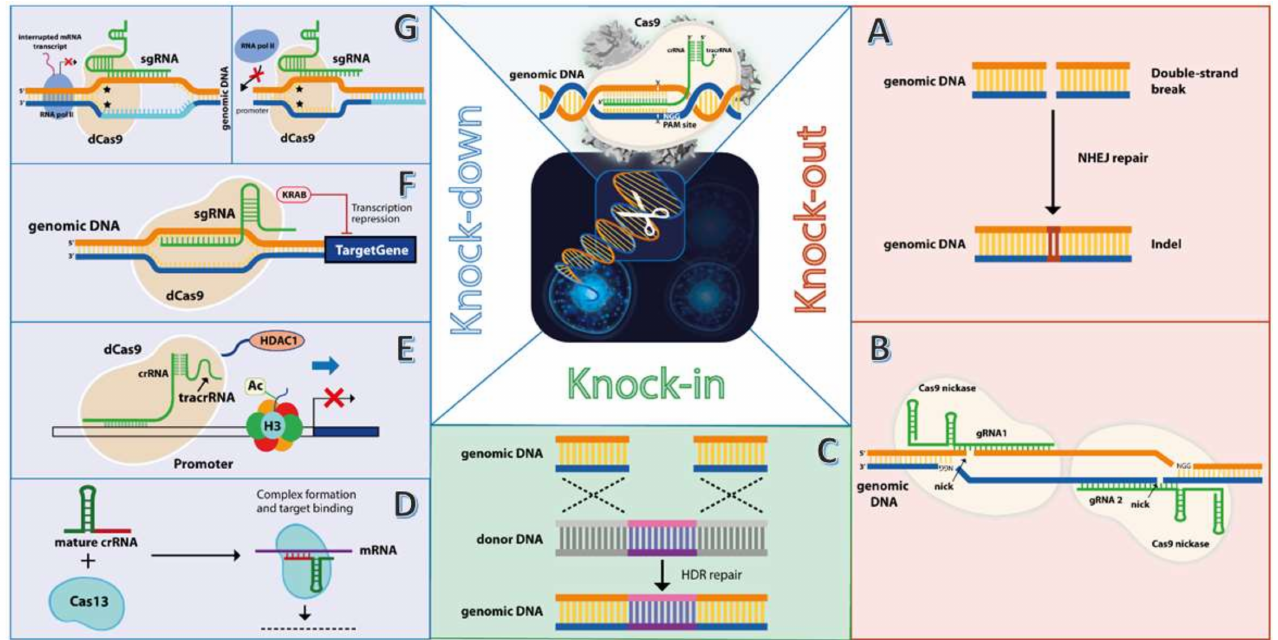
Figure 1. Approaches for gene editing in tumor cells using CRISPR/Cas system. The classical CRISPR/Cas9 effector ribonucleoprotein (RNP) (upper middle image) features the Cas9 nuclease and guide RNA (gRNA), comprising two sequences, the CRISPR RNA (crRNA) which shares